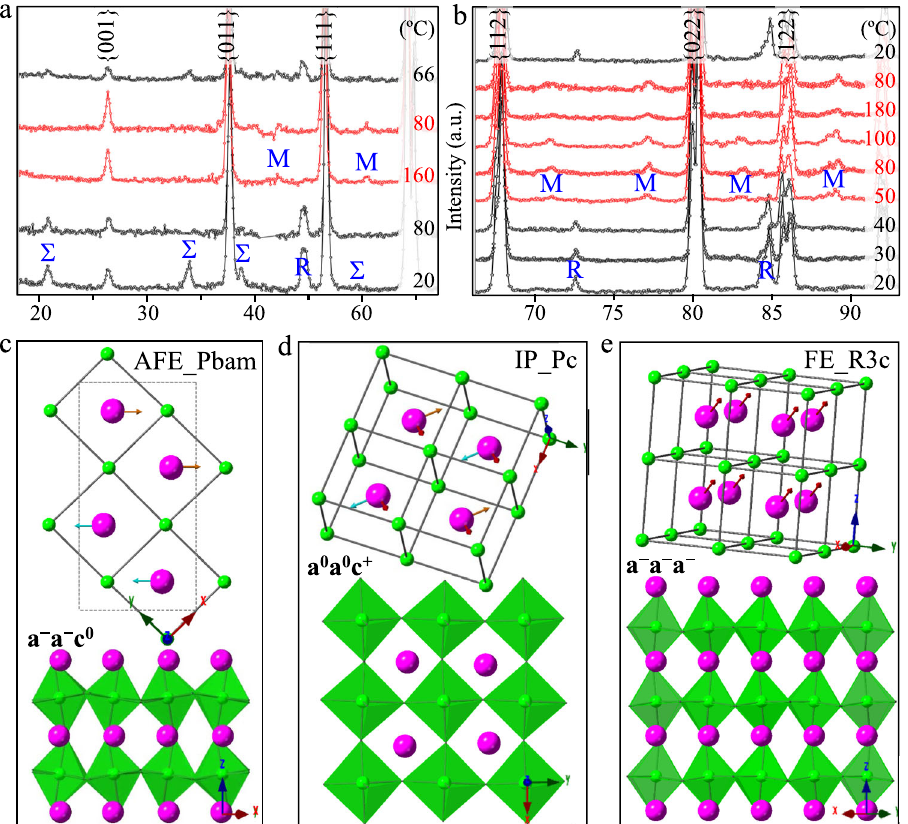
Fig. 2 Average structural investigations. a , b In-situ neutron diffraction patterns of temperature-induced phase transitions of IP-AFE in PZTN98/2 and IP- FE in PZTN97/3, respectively. The patterns of IP are presented in red color. The Σ -type represents quadruple superlattice re fl ections while the R-type and M-type represent double superlattice re fl ections with characteristic indices of 1/2{ ooo } and 1/2{ ooe }, respectively. c ‒ e The behavior of Pb-cations displacement and oxygen octahedra tilts in AFE, IP and FE phase, respectively. The structural models are drawn based on the Rietveld re fi nement using Pc (taken at 80 °C of PZTN97/3), Pbam (taken at 20 °C), and R3c (taken at 20 °C). The projections of octahedra tilts in IP, AFE and FE phases are along [001] p , [1 (cid:1) 10] p and [110] p directions, respectively. The x, y, and z directions refer to pseudocubic displacement. The two types of modulations are represented by better visualization to show the gradient change of lattice spacing Pb displacement maps in Fig. 3d, e, where the horizontal com- across antiphase boundaries. ponents associated with M-type superlattice re fl ection are high- Figure 5 models an ideal atomic representative for a large-scale lighted with orange and cyan arrows. picture to make a further clearer description of IP state. In this model, the Pb displacements are coupled with oxygen octahedral tilts and the Zr/Ti displacements are assigned as zero because they are signi fi cantly smaller than Pb displacements. Figure 5a clearly shows that the horizontal component of Pb displacements gra- dually decreases towards an APB while the vertical component of Pb displacements maintains. Figure 5b presents that the tilt angle of oxygen octahedra, which is represented by gradation of color, also decreases gradually across the APB. Figure 5c further illus- trates combination of gradient oscillation of Pb horizontal dis- placements and oxygen octahedra tilts via a schematic pro fi le. It can be seen that the average structure by simple superposition of APB and APD still exhibits inphase octahedra tilt and coexistence of parallel and antiparallel Pb displacements, which is consistent with the one derived from neutron diffraction. It should be noted that the alternating arrangement of antiphase boundary and antiphase domain involves lattice spacing exhibiting periodical gradient oscillation in the whole crystal, which cannot be de fi ned as a long-range ordered single crystal with a determined sym- metry or space group. After clarifying the structural characteristics of IP, the tri-state transition among AFE, IP and FE can be comprehensively understood from three aspects.